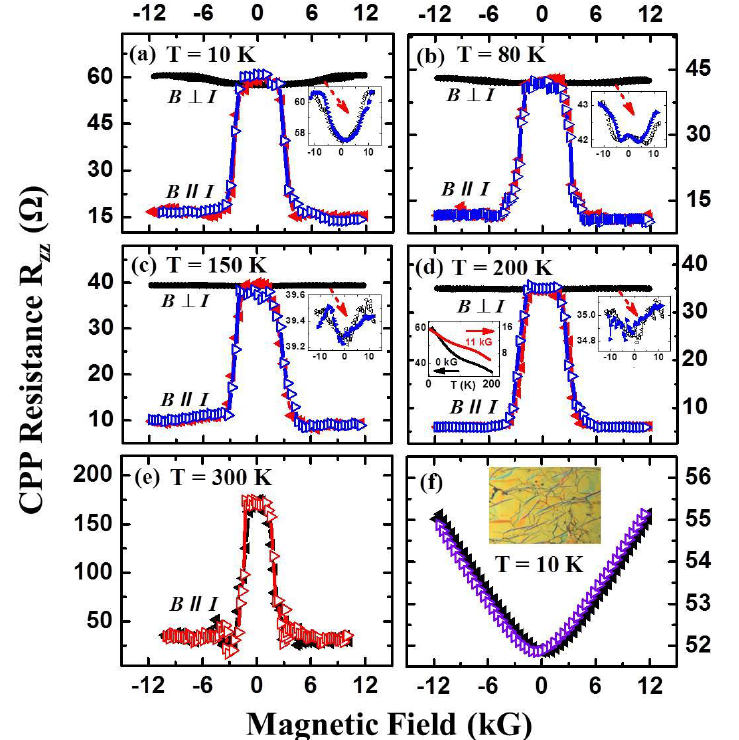
Figure 3. CPP resistance ( R ) of MLG on Ni devices in the temperature range zz 10–200 K. ( a – d ) Large negative MR, which is almost independent of temperature, is observed in B || I geometry. For each temperature, MR for both field orientations (B || I and B I) is shown. The left inset in ( d ) shows the temperature dependence of CPP resistance at zero and high magnetic fields; ( e ) room temperature large, negative MR data observed in another MLG on Ni sample; ( f ) R vs . B for Ni-grown MLG after transferring on the Cu zz substrate. No negative MR is observed. ( Inset ) Optical microscopic image of MLG transferred on the Cu substrate. A constant current bias of 1 mA is applied for all resistance measurements. Each resistance value is an average of 50 readings. Both scan directions are presented, and no MR hysteresis is